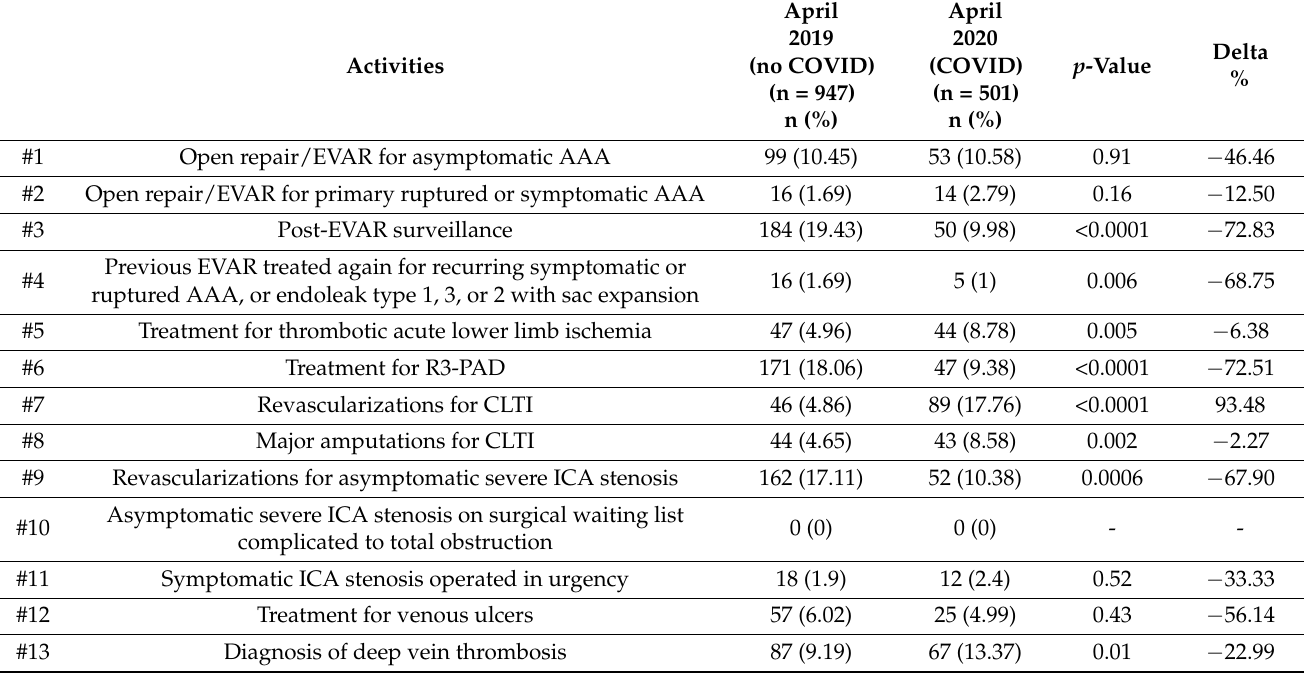
Table 3. Summary of the responses to the questionnaire for the COVID-19 month of April 2020 compared with the non-COVID-19 month of April 2019.